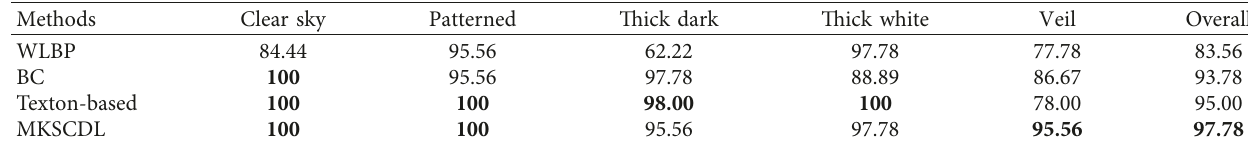
Table 3: Recognition rates of different methods in 40/45